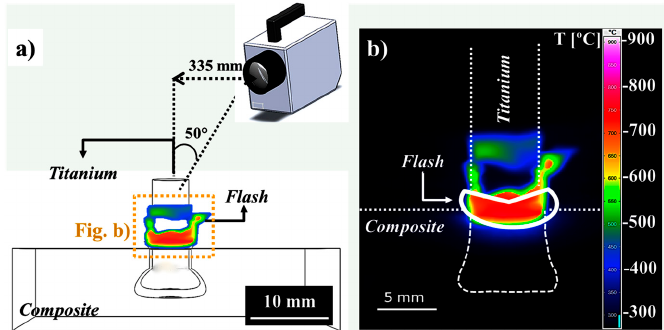
Figure 4. ( a ) Schematic configuration of infrared thermography showing the distance between the thermocamera and the joint and the flash where the temperature was recorded; ( b ) example of a thermogram showing the maximum process temperature. The continuous white line in ( b ) delimits the monitored area.